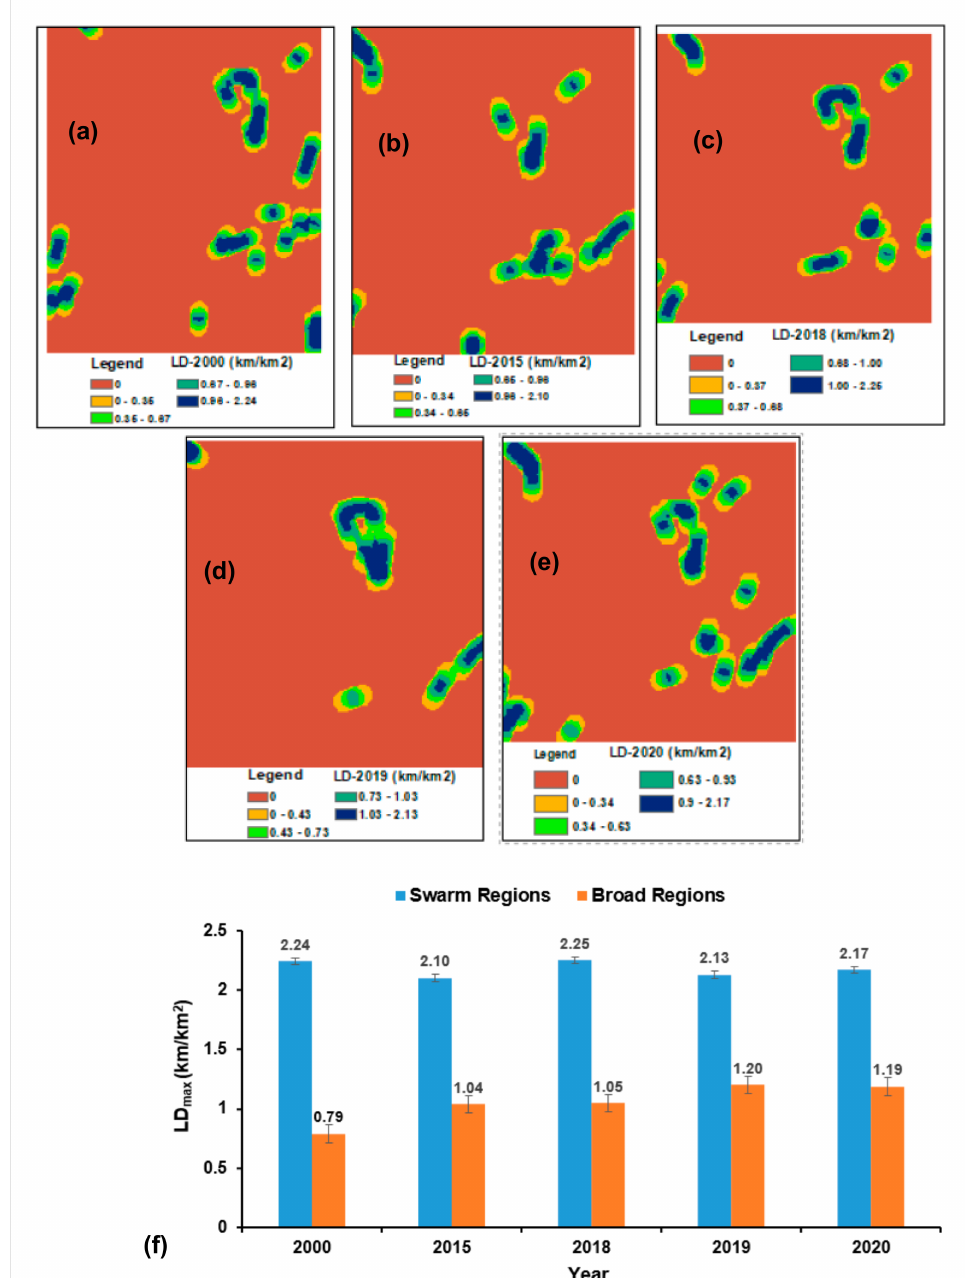
Figure 5. LD distribution of the swarm regions and its comparison with broad regions during 2000–2020; ( a ) LD distribution of 2000 of the swarm regions; ( b ) LD distribution of 2015 of the swarm regions; ( c ) LD distribution of 2018 of the swarm regions; ( d ) LD distribution of 2019 of the swarm regions; ( e ) LD distribution of 2020 of the swarm regions, and ( f ) LD max value comparison in swarm regions with broad regions to know stress development pattern through the similar time